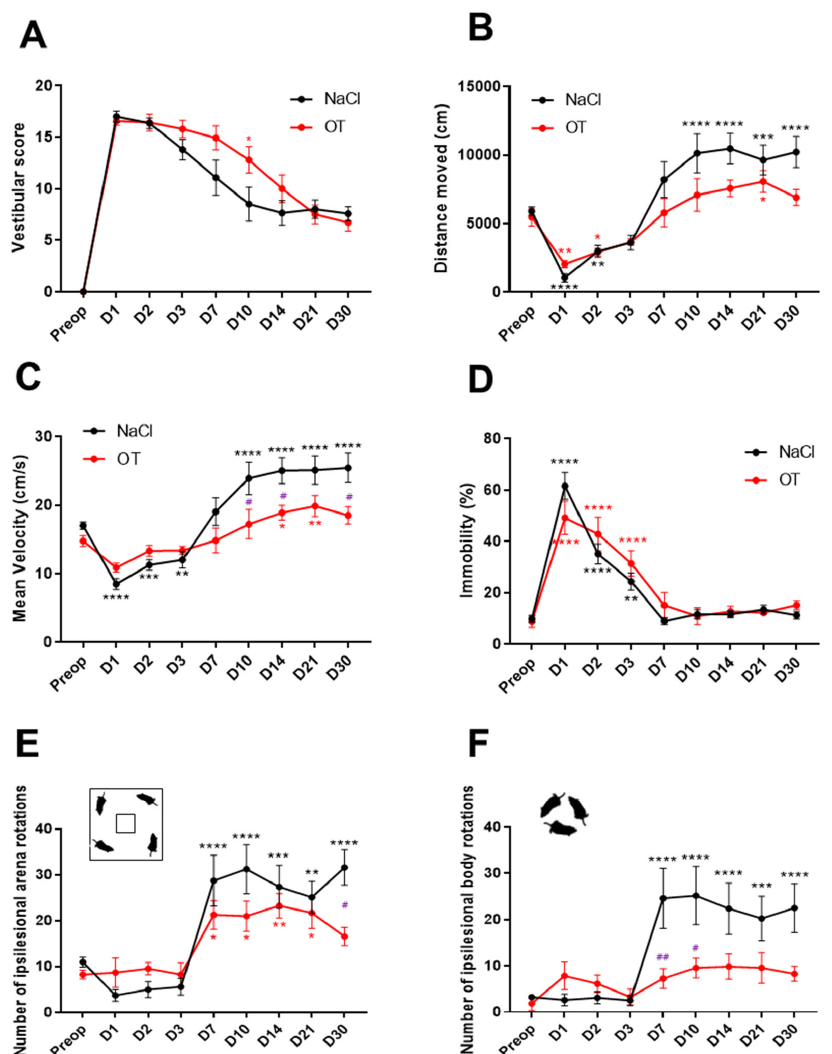
Figure 1. Behavioral assessment of the vestibular syndrome of oxytocin-treated animals. ( A ) Qualitative assessment of the vestibular syndrome over postlesion days of control UVN rats (NaCl in black, n = 8) and oxytocin ‐ treated UVN rats (OT in red, n = 7). ( B ) Assessment of the distance traveled by UVN ‐ NaCl and UVN ‐ OT rats in the open field. ( C ) Assessment of the mean velocity by UVN ‐ NaCl and UVN ‐ OT rats in the open ‐ field. ( D ) Assessment of the % of time immobile by UVN ‐ NaCl and UVN ‐ OT rats in the open ‐ field. ( E ) Mean number of ipsilesional (left) arena rotations by UVN ‐ NaCl and UVN ‐ OT rats in the open ‐ field. ( F ) Mean number of ipsilesional body rotations by UVN ‐ NaCl and UVN ‐ OT rats in the open ‐ field. Error bars represent standard error of the mean (SEM). * p < 0.05, ** p < 0.01, *** p < 0.001, **** p < 0.0001. A significant difference from the preoperative value is indicated by * in black for the UVN ‐ NaCl group and in red for the UVN ‐ OT group. A significant difference between the UVN ‐ NaCl and UVN ‐ OT rats is indicated by # in purple.